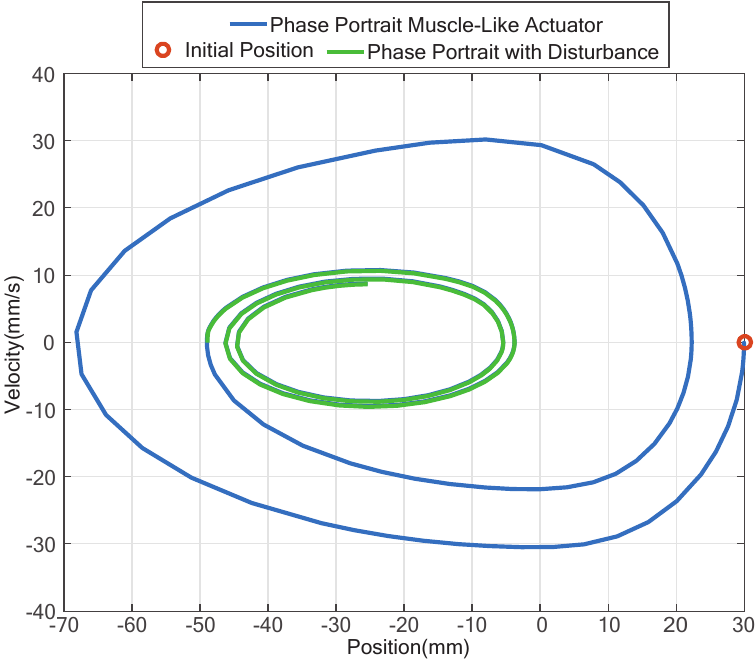
Figure 11. Velocity switching with disturbance